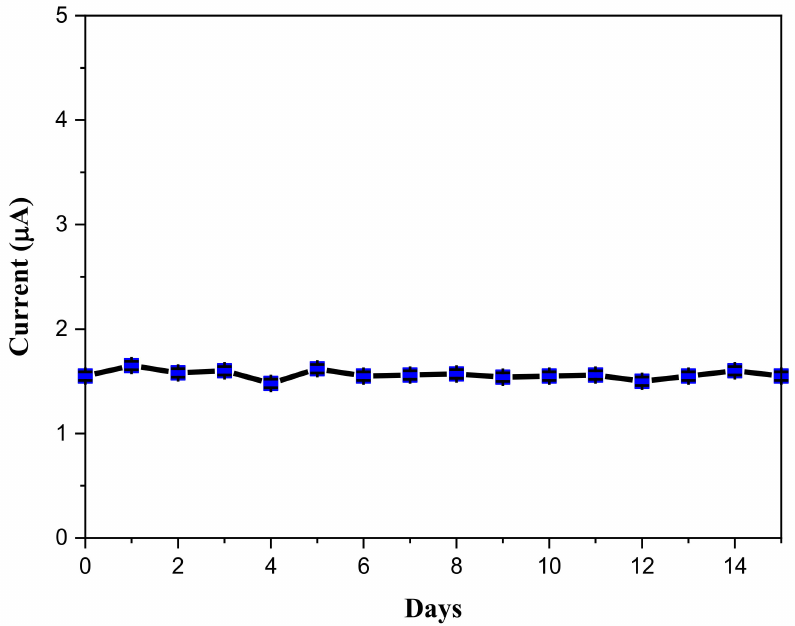
Figure 7. The stability test of the 1% Pd/BiVO 4 /GCE on 3.4 µ M